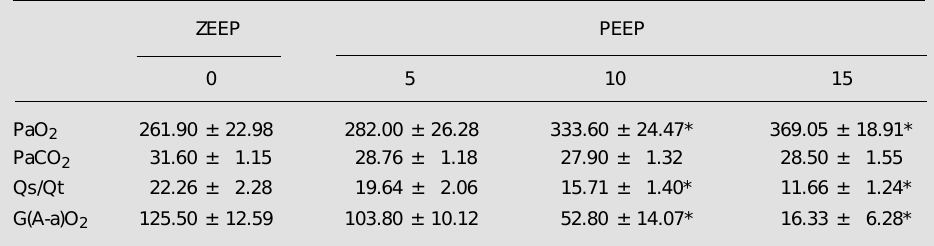
Table 4 - Peripheral oxygenation